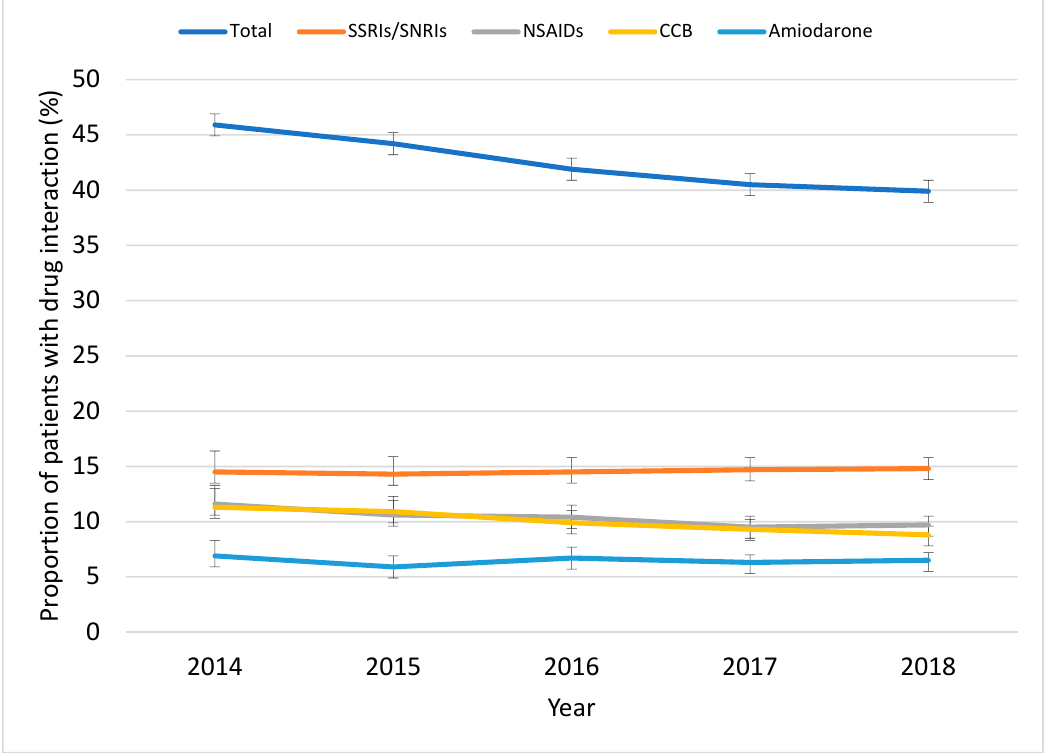
Figure 1. Trends in potential drug interactions in patients taking direct-acting oral anticoagulants. Table 1. Concomitant medications prescribed with direct-acting oral anticoagulants in 2018. Concomitant Medications